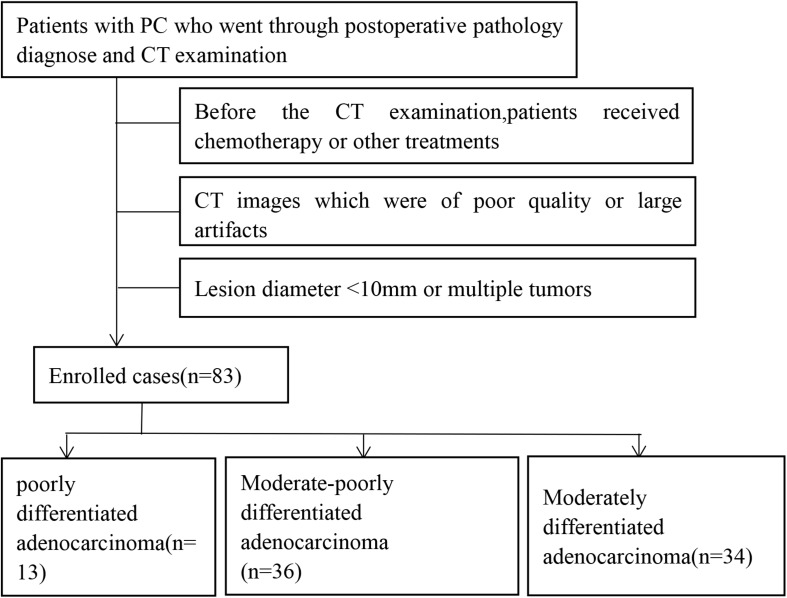
Screening and grouping flow chart of enrolled cases in this study.